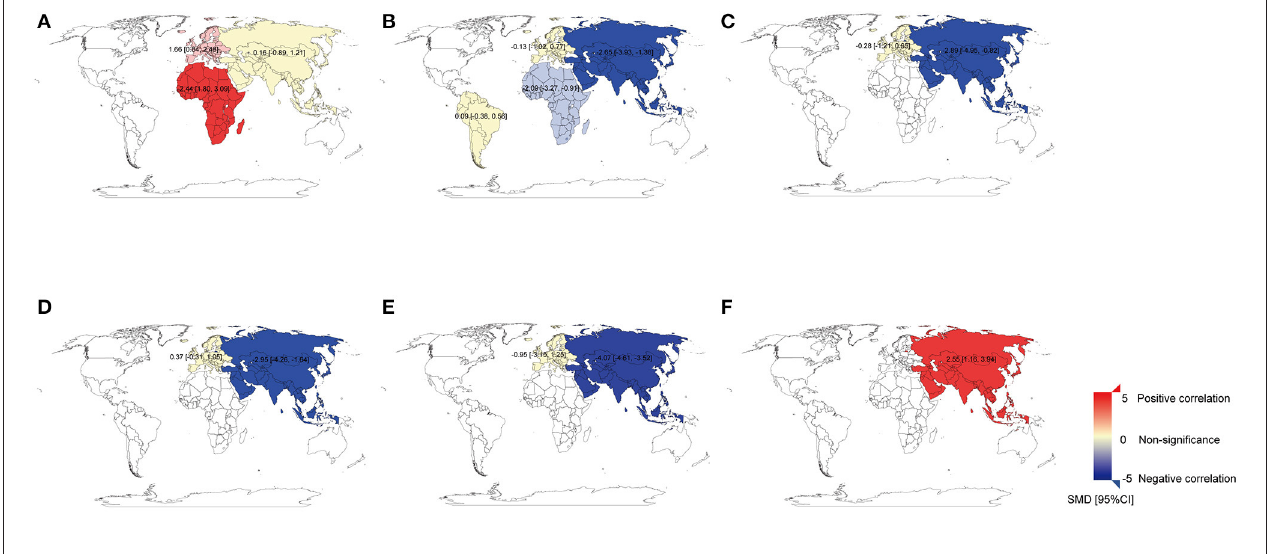
FIGURE 3 | The world map for the associations between heavy metals and breast cancer. (A) The world map for the association between Cu and breast cancer in plasma/serum. (B) The world map for the association between Zn and breast cancer in plasma/serum. (C) The world map for the association between Zn and breast cancer in hair. (D) The world map for the association between Mn and breast cancer in plasma/serum. (E) The world map for the association between Mn and breast cancer in hair. (F) The world map for the association between Cd and breast cancer in plasma/serum. The standard mean differences (SMD) and 95% confidence intervals (CIs) were calculated using the random-effects model and remarked in the maps by regions. Cu, copper; Zn, zinc; Mn, manganese; Cd,